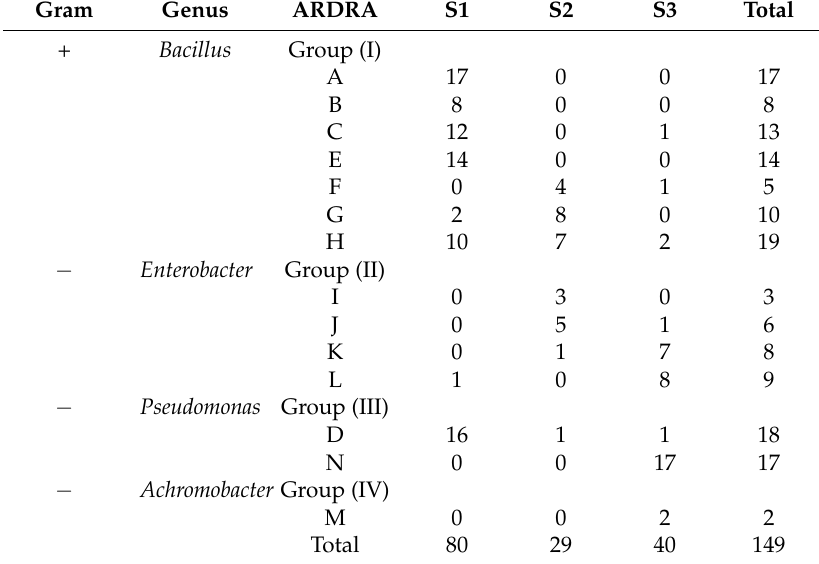
Figure 2. Dendrogram of different denitrifying isolate types. The dendrogram was based on 16S Amplified Ribosomal DNA Restriction Analysis (ARDRA) patterns obtained from soils S1, S2, and S3. The letter indicates the ARDRA type and the numbers in parentheses are the numbers of isolates for each type. Table 4. Number of isolates from samples S1, S2, and S3, classified by Gram typing, sequence analysis, and Amplified Ribosomal DNA Restriction Analysis (ARDRA) typing.